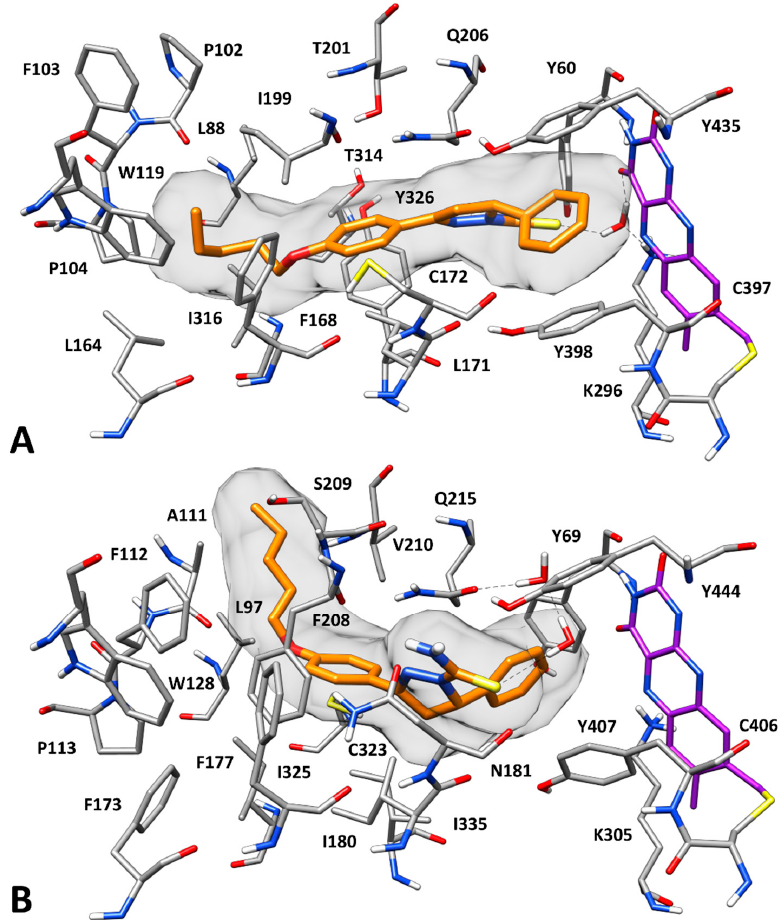
Figure 3. Predicted binding mode of ( S ) ‐ P5 into hMAO ‐ B ( A ) and hMAO ‐ A ( B ). For clarity, only the flavin group of the cofactor is shown in purple. The molecular surface of the ligand is shown in gray. Based on the binding modes predicted for the two compounds ( S ) ‐ P5 and ( R ) ‐ P5 into hMAO ‐ A and hMAO ‐ B, few considerations can be derived. The thioamide moiety of the ligands is important for both the H ‐ bond donor NH 2 group and the H ‐ bond acceptor sulfur atom, with this last portion that seems to be a fundamental feature. This is consistent with the observation that derivatives with the thioamide moiety replaced by an acetyl group maintain micromolar activity. The different disposition assumed by the alkoxyl chain of the ligands into hMAO ‐ A and hMAO ‐ B could explain why compounds with longer chains are more selective over hMAO ‐ B than those bearing shorter chains like ( R ) ‐ P3 : a shorter chain would limit not only the favorable hydrophobic interactions with the lipophilic pocket of hMAO ‐ B, but also the possible unfavorable interactions with the solvent when bound to hMAO ‐ A, thus balancing the activity of the inhibitor toward the two enzyme isoforms. Finally, the inactivity of derivatives bearing bulky groups connected to the pyrazoline core